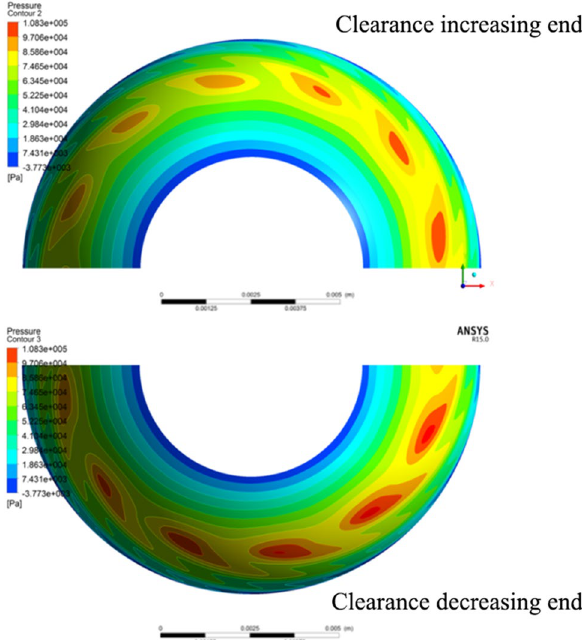
Figure 9. Pressure distribution of gas film under different radial